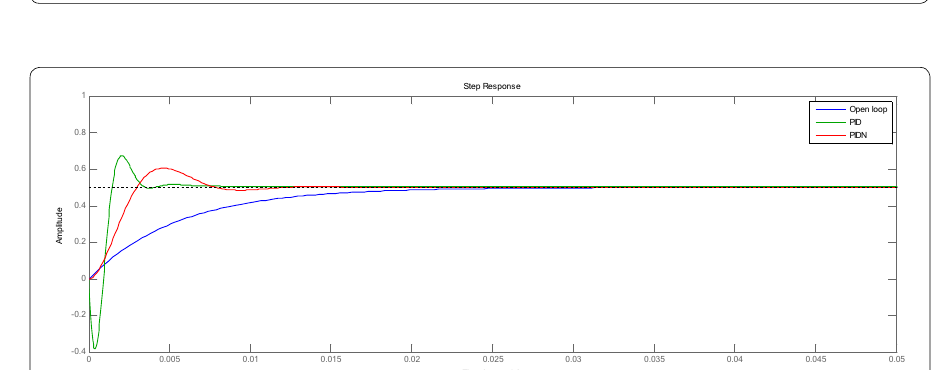
Table 5 Step response of BBC with PID and PIDN and without PID in buck mode BBC Peak amplitude Overshoot Rise time in seconds Settling in volts Open